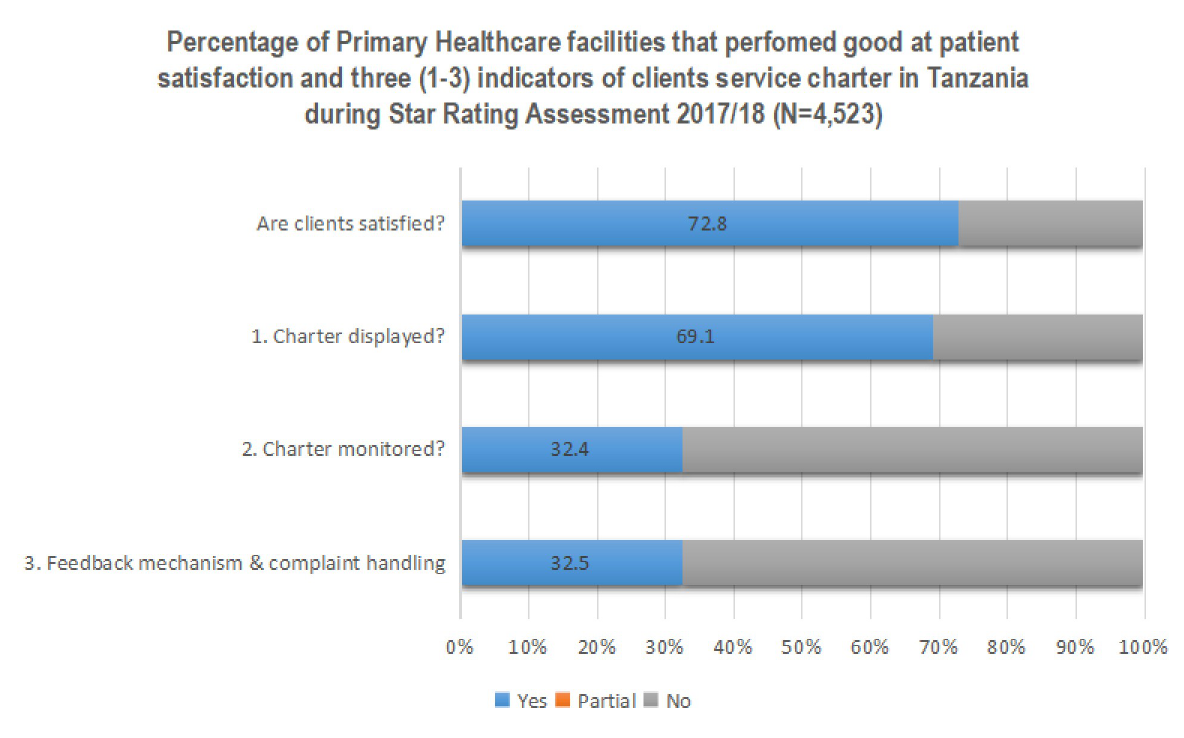
Fig 2. Proportion of primary healthcare facilities whose clients are satisfied with services and the status of implementation of clients’ service charter in Tanzania.